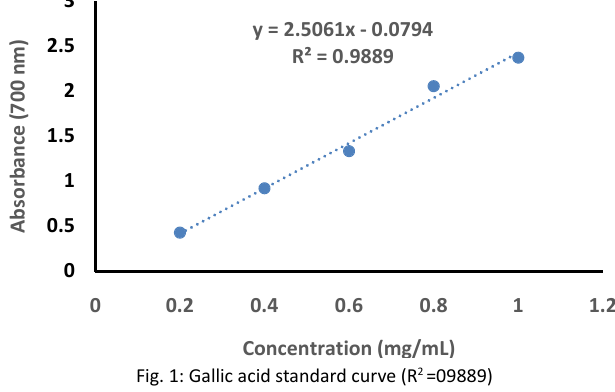
y = 2.5061x ‐ 0.0794 R² = 0.9889